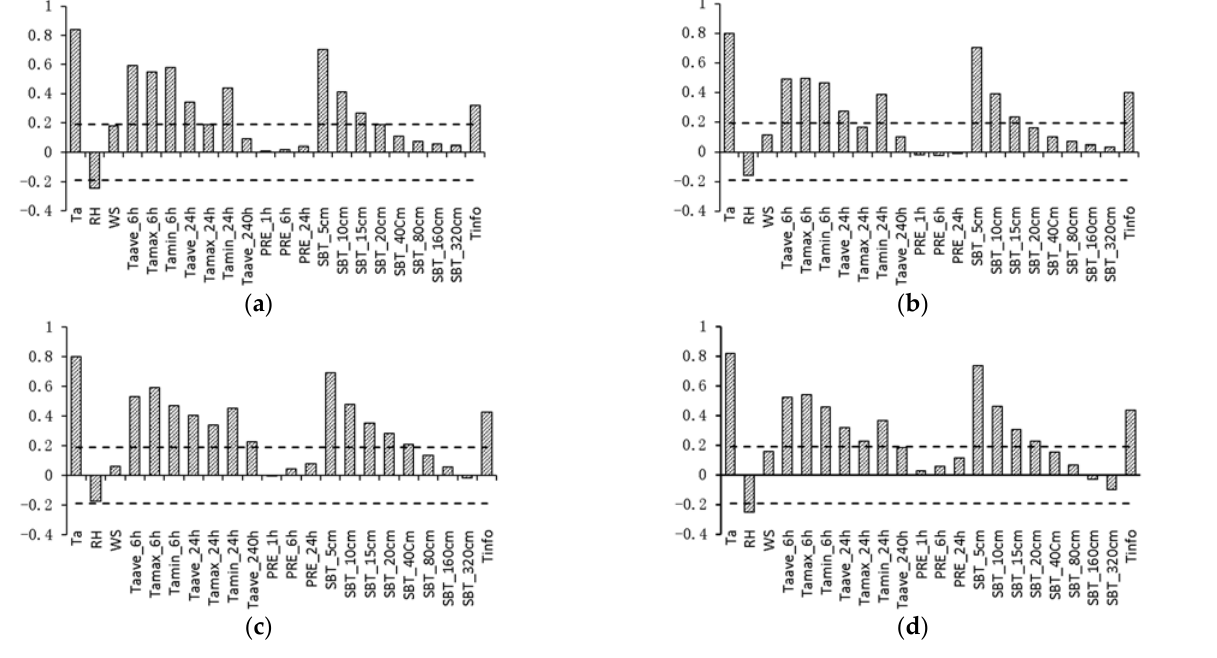
Figure 5. Correlation coefficient between surface temperature and other meteorological factors at ( a ) road surface station 1, ( b ) road surface station 2, ( c ) bridge deck station 1, ( d ) bridge deck station 2 (dashed line represent the significant level of 0.05).